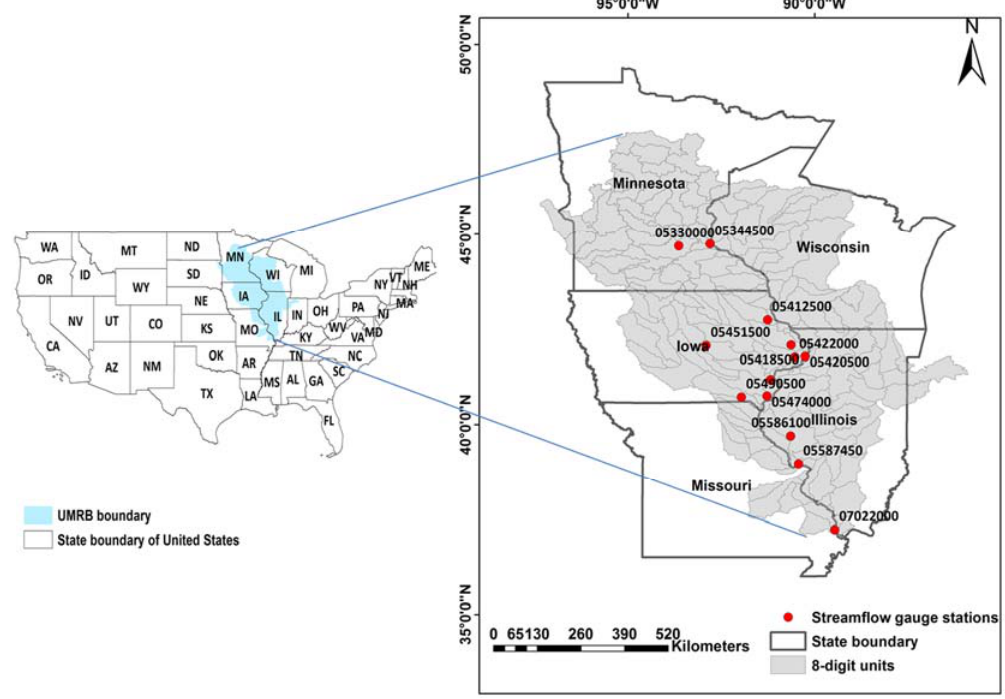
Figure 1. Location of the UMRB displaying 8-digit Hydrological Unit Codes (HUCs) or watersheds and streamflow gauge stations used in this study.